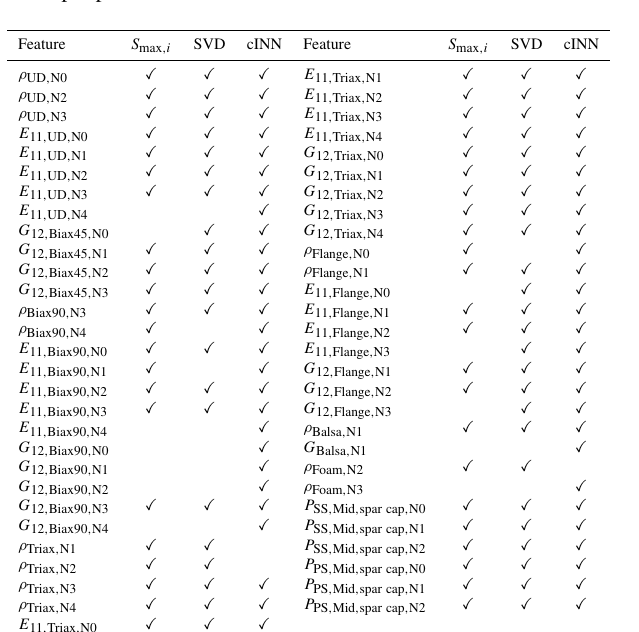
Table A1. Comparison of the feature selection performed by the sensitivity analysis (SA) and directly with the cINN applied to the full input parameter set.